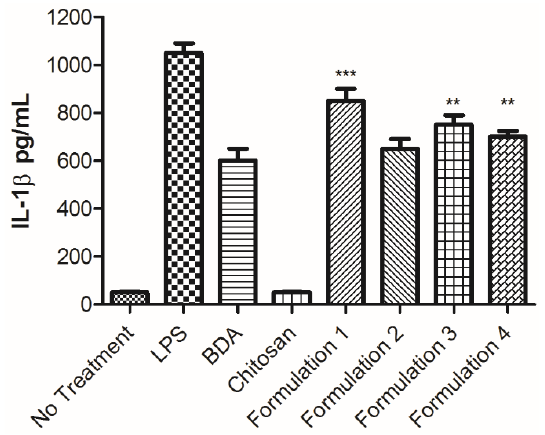
Figure 2. Levels of IL- 1β produced by JAWSII after 48 h. JAWSII, immortalized bone-marrow-derived dendritic cells, were seeded at a concentration of 10 6 cells/mL/well in a 12-well plate and left untreated or treated with either 1 μg/mL LPS from E. coli 0111:B4, vaccine components (bacterial derived adjuvant (BDA): 1 μg/ mL, chitosan: 10 μg/mL), or the different peptides (1–4) containing formulations (1 μg/mL based on BDA). Supernatants were collected from the cells after 48 h of treatment and levels of IL- 1β were analyzed via ELISA. N = 6 ± SEM. Statistical significance was determined by an ANOVA with a Tukey HSD. *** p < 0.001 and ** p < 0.01 as compared to BDA.